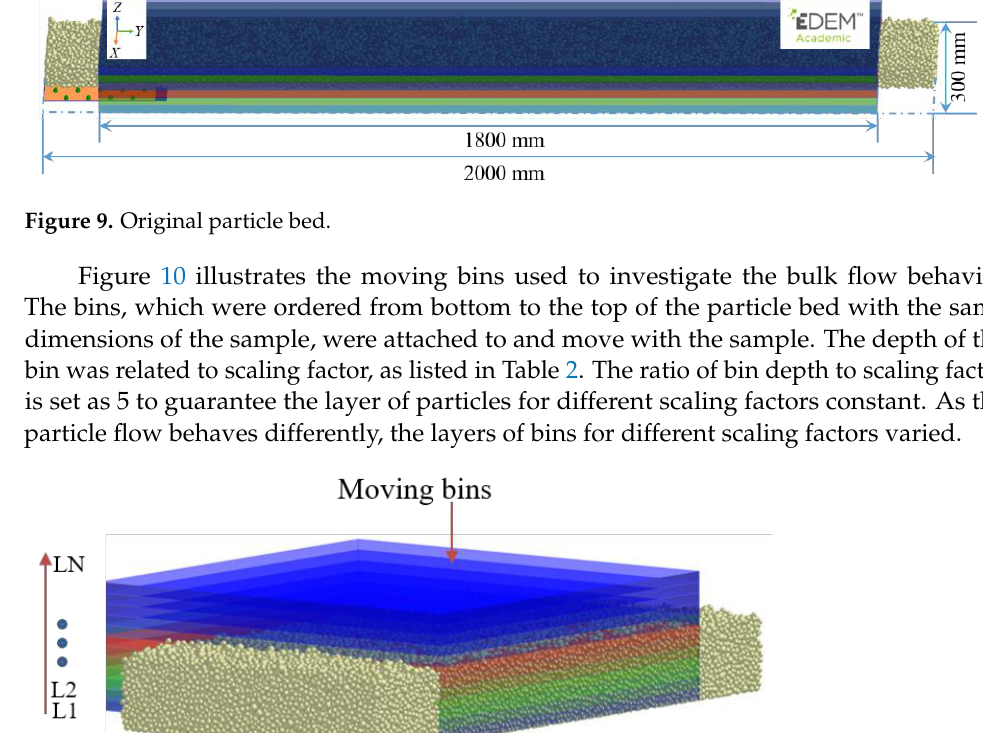
Figure 10. Moving bins. Table 2. Sizes and layers of the